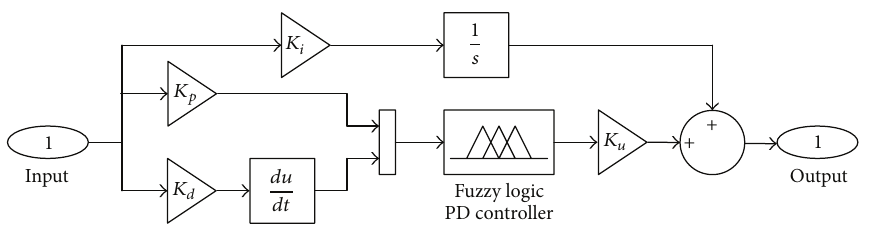
Figure 8: The block diagram of FPD PID strategy.